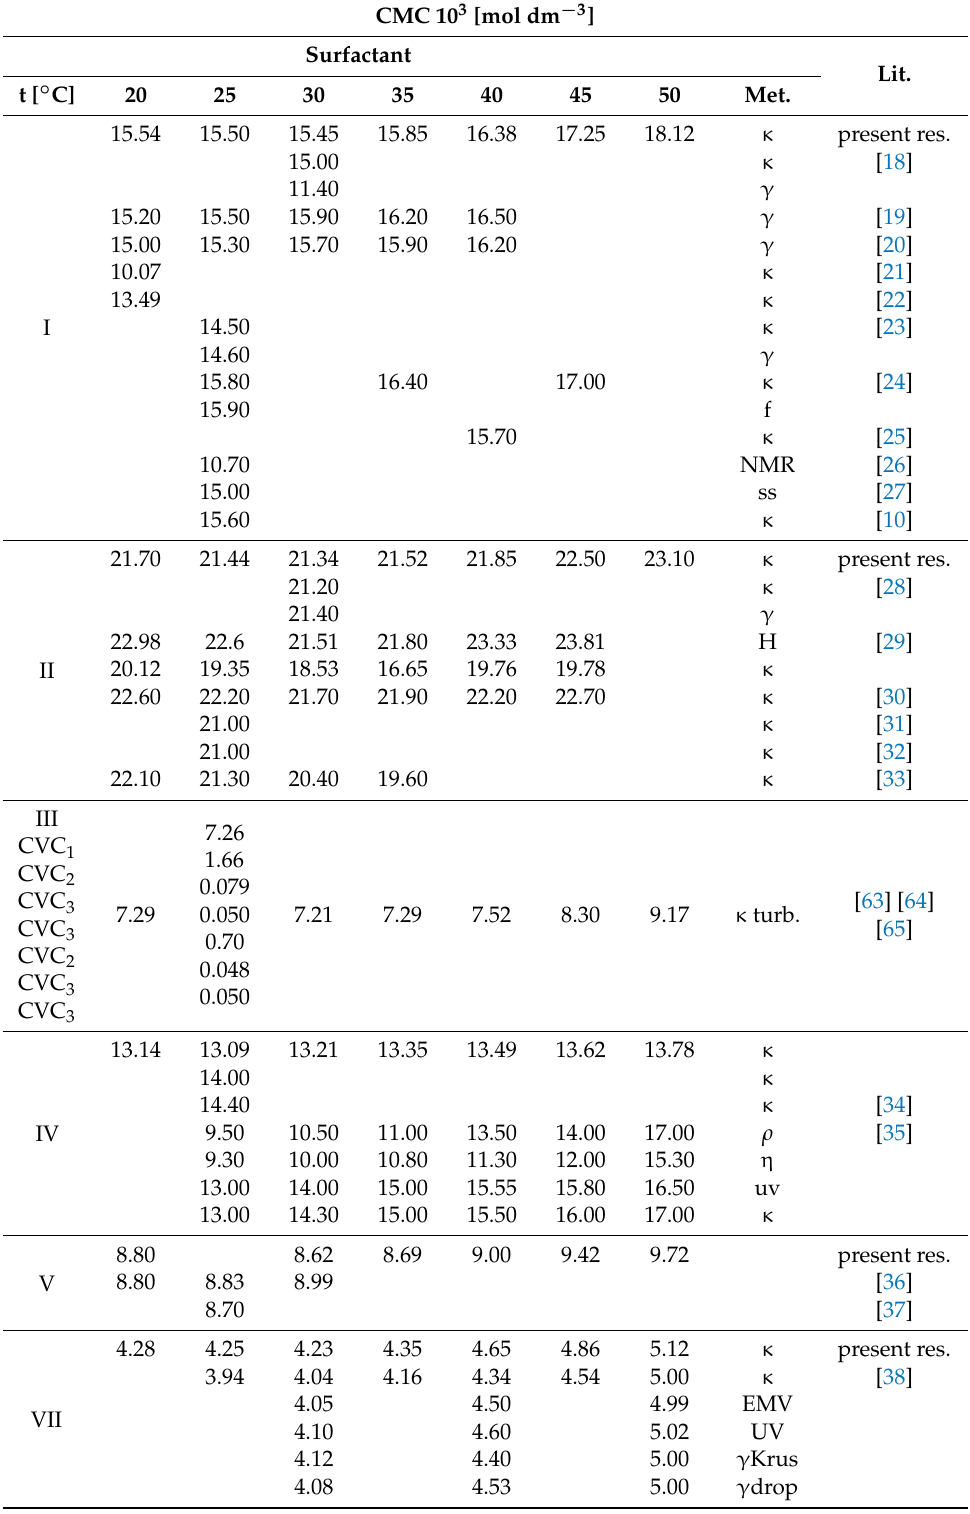
Table 4. Comparison of established CMCs with those obtained by some other